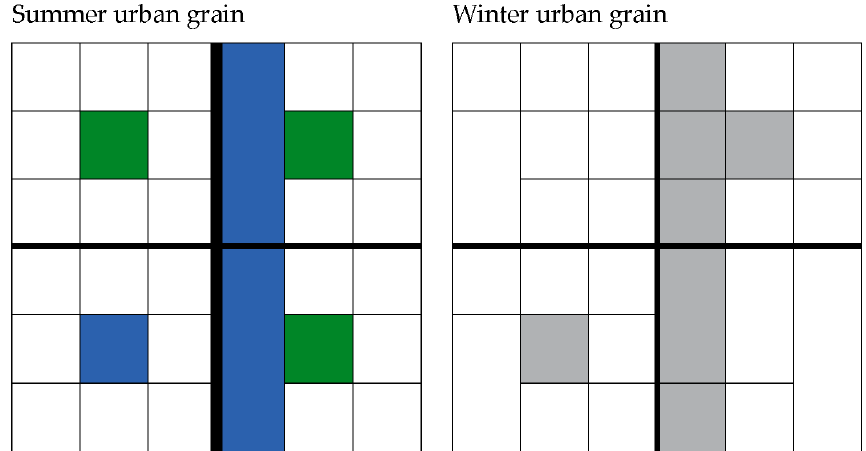
Figure 7. Diagrammatic illustration of how the interaction between the urban form and winter season were seen to be capable of altering an areas urban grain. Black lines indicate pathways, green areas are public spaces, and blue indicates water. The grey illustrates the white space created by winter.